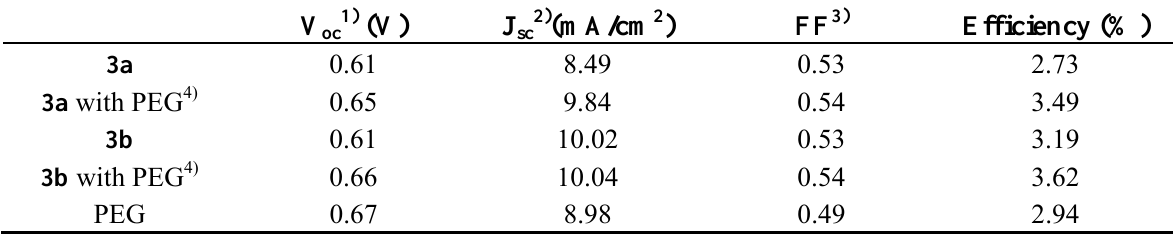
Table 3. The photovoltaic Performances of FTO/TiO 3a , 3a with PEG, 3b , and 3b with PEG under AM 1.5